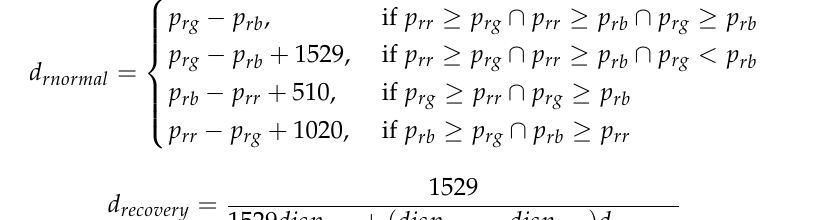
Figure 2. The hue color scale used for the colorization process. Although color images from the colorization are used to visualize, save, and detect a person, depth features are employed for the feature extraction process. Consequently, af- ter completing the person detection process, the depth values (distance values) of the de- tected person have to be restored from the colorized images (color values). For this pur- pose, we calculate depth image recovery from the colorized images to extract depth fea- tures, using (6) and (7) from the same whitepaper [19]. The procedure for alternating pixel values between depth and color is shown in Figure 3.